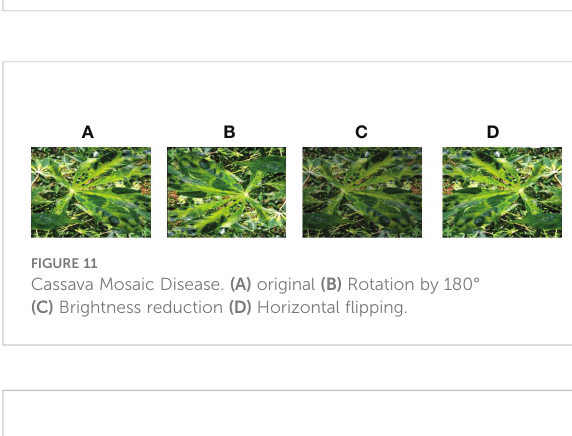
FIGURE 10 Cassava Green Mottle. (A) original (B) Rotation by 180° (C) Brightness reduction (D) Horizontal fl ipping.